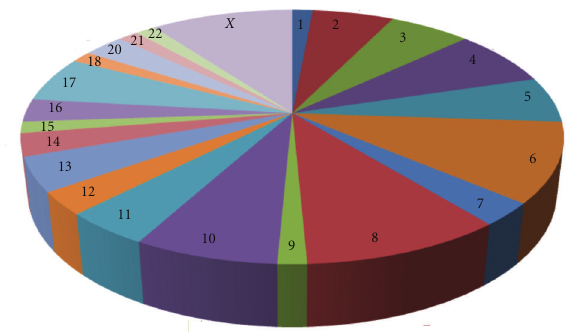
Figure 1: Pie distribution of mir-548 gene family in human chromosomes. The location of mir-548 gene family members is detected in human chromosomes except chromosomes 19 and Y . Note that 30.43% of the members are located in chromosomes 6, 8, and X .